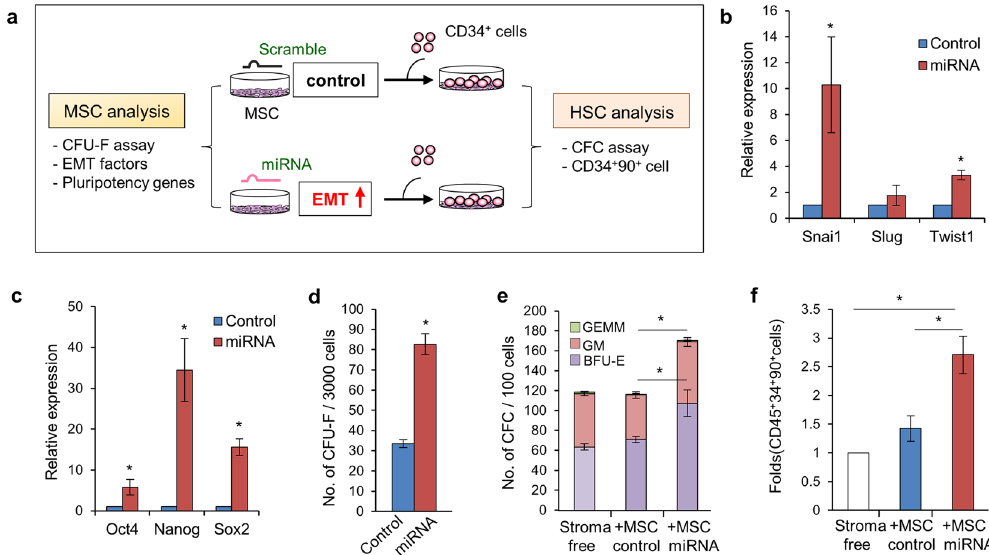
Figure 6. Driving the EMT in 2D-MSCs reproduced the characteristics of 3D spheroid MSCs. ( a ) Schematic of the experimental design. BM-derived MSCs in 2D adherent culture were transfected with miRNA mimetic oligonucleotides for miRNAs promoting the EMT and inhibitory nucleotide for miRNAs suppressing the EMT (miRNA lists and oligonucleotide sequences are shown in the Supplementary Table S5). ( b – d ) Effects of EMT-driving miRNAs on 2D MSCs. The expression levels of indicated master EMT-regulatory gene ( b ) or pluripotency gene ( c ) were analyzed in 2D-MSCs transfected with miRNA compared to control (scramble)- transfected MSCs. Relative expression folds are shown with SEM (three experiments). ( d ) Effects of the EMT on mesenchymal progenitors. Shown are the numbers of CFU-F obtained from 3000 MSCs transfected by each miRNA group (three experiments). ( e and f ) Effects on the expansion of primitive hematopoietic population. After 3 days of coculture of CD34 + cells with MSCs transfected with each group miRNAs, the numbers of CFCs of each lineage ( e ) and primitive repopulating hematopoietic progenitors (CD34 + 90 + ) ( f ) are shown (mean ± SEM; three experiments; * p <